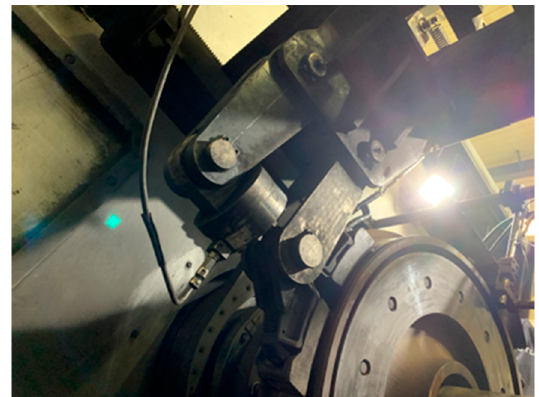
Figure 5. High-speed train brake-testing machine.